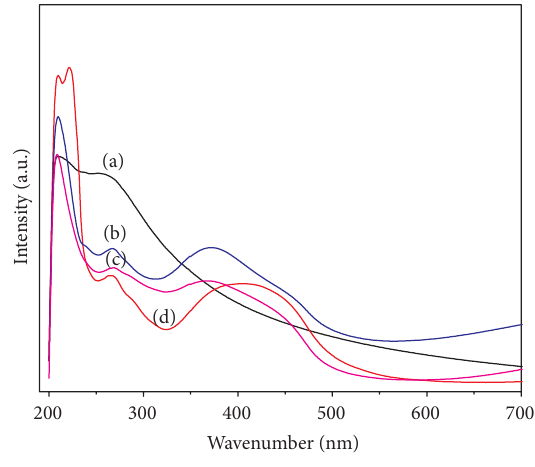
Figure 6: UV-visible spectra of the CNT-COOH (a), CNT/PANI composite prepared in HCl (b) and HNO 3 (c) medium, and pure PANI (d) in ethanol.